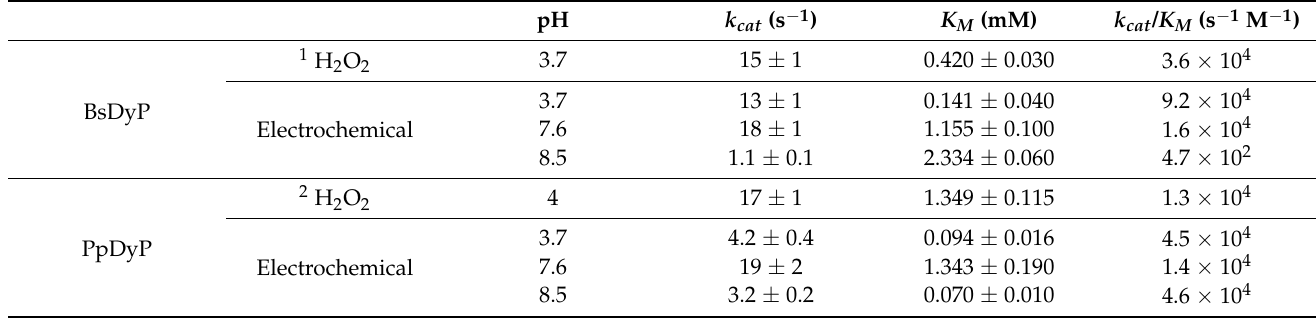
Figure 6. Steady-state kinetic analysis of the aerobic electrocatalytic oxidation of ABTS at pH 7.6, 298 K and a poised potential of − 0.190 V for BsDyP ( A ) and PpDyP ( B ). Table 2. Apparent steady-state catalytic parameters of BsDyP and PpDyP for ABTS oxidation performed under two different conditions: (i) using H 2 O 2 as electron source and (ii) in the absence of H 2 O 2 at an applied potential of − 0.190 V and aerobic atmosphere. All measurements were done at 298 K.